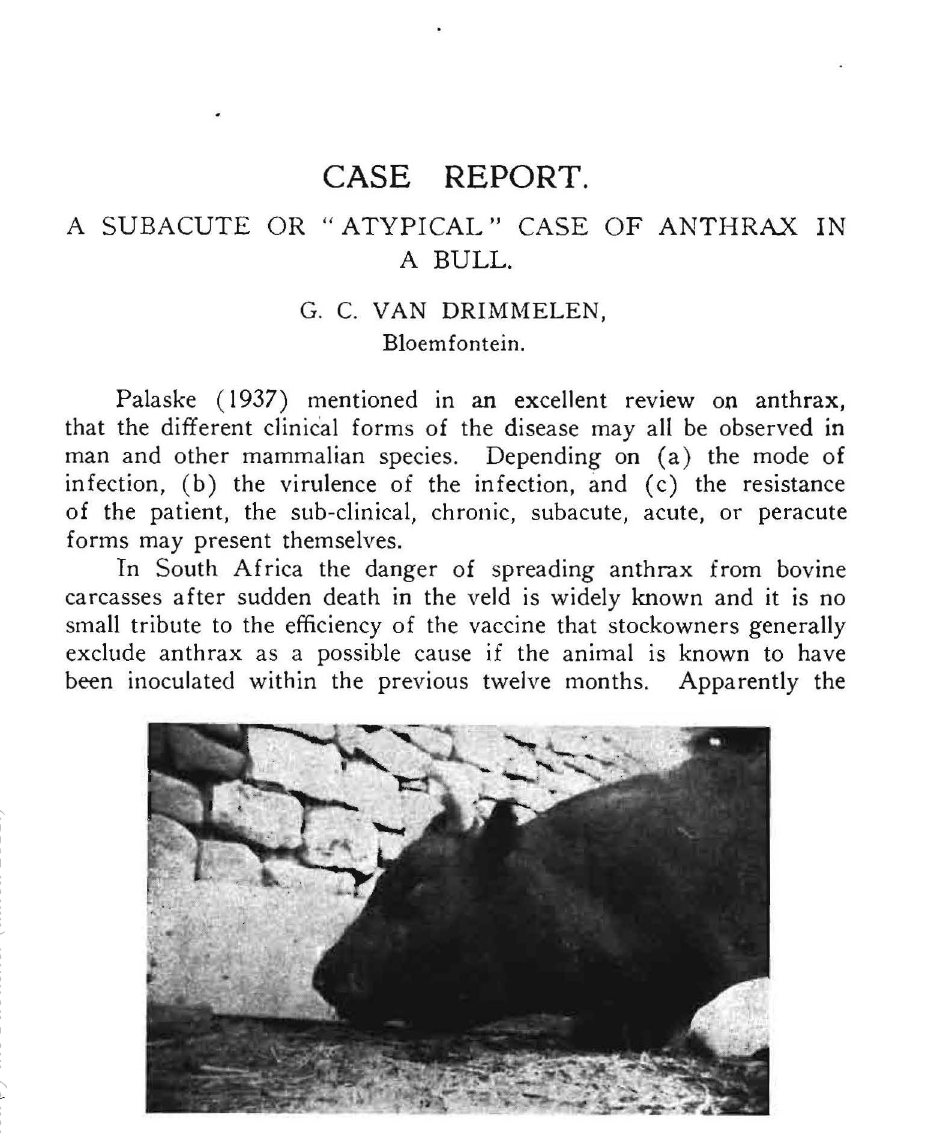
Fig 1. - Photograph of affected parts of a pttre-bl'ed Friesland bull suffering from subacute anthrax of the throat and neck, with "?evere asphyxiating oedema of all the soft tissues around the pharynx. Taken twelve hours before death 011 the seventh day of